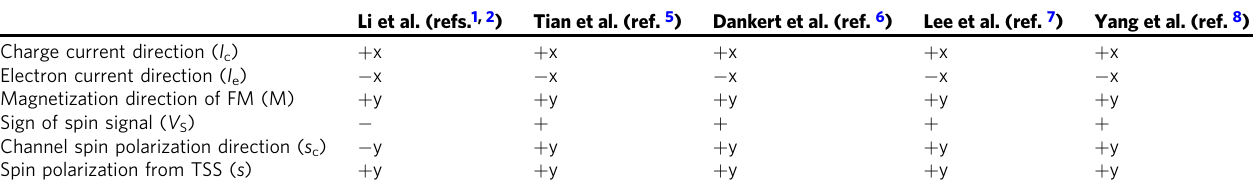
Table 1 Comparison of the reported results on CISP in 3D TIs measured by spin potentiometry Li et al. (refs. 1, 2 ) Tian et al. (ref. 5 ) Dankert et al. (ref. 6 ) Lee et al. (ref. 7 ) Yang et al. (ref. 8